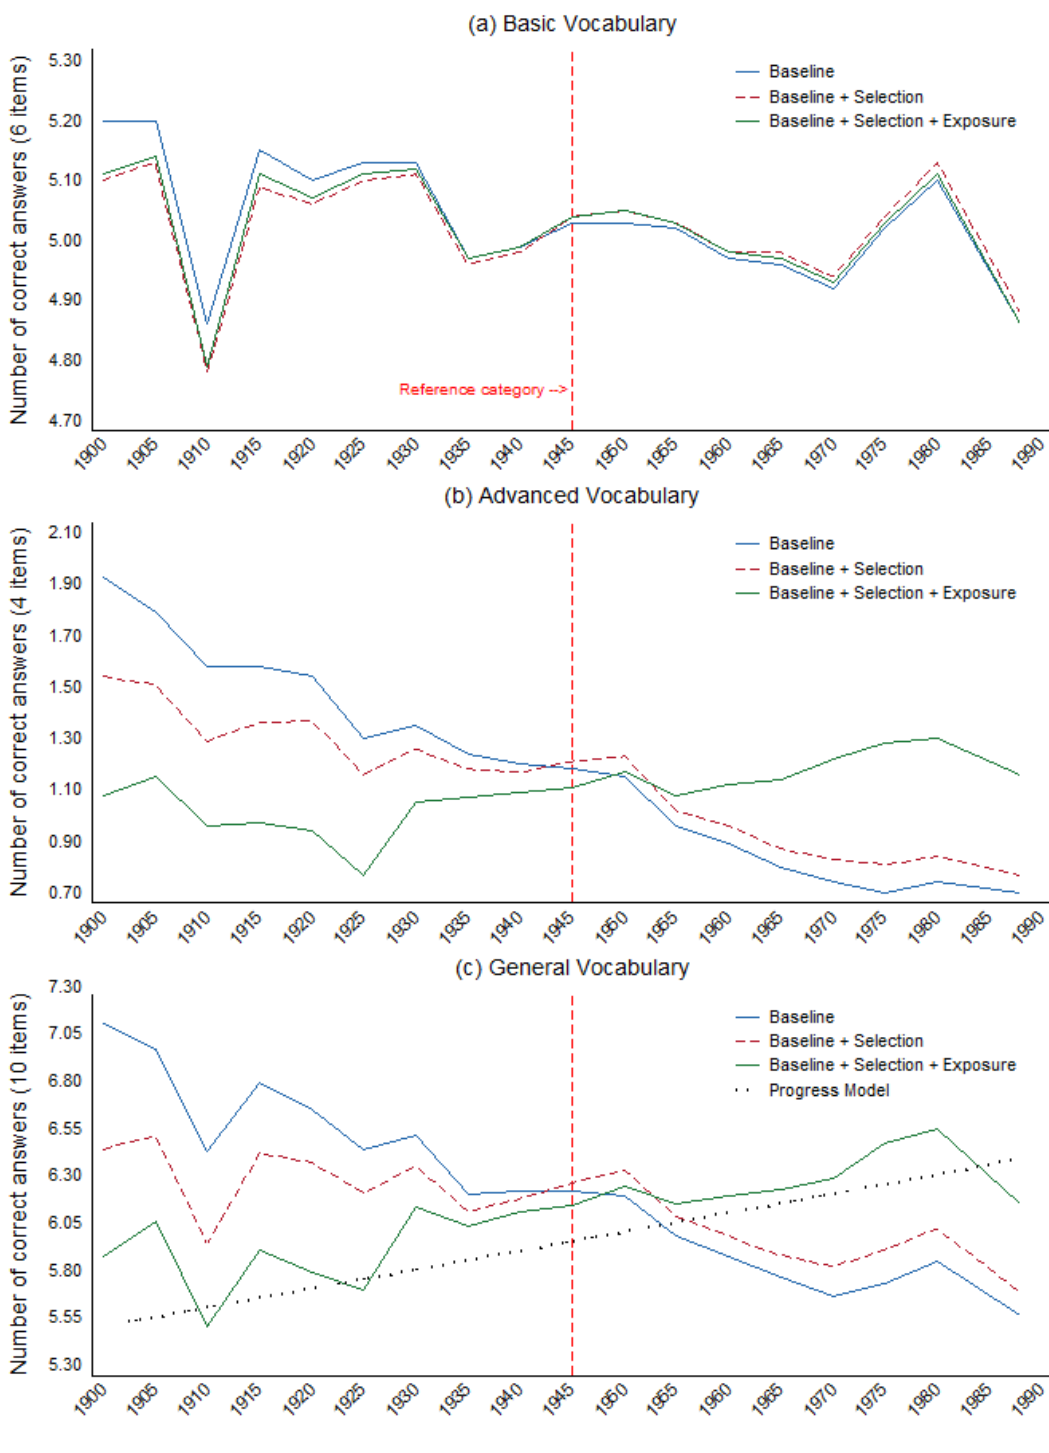
Figure 4: Adjusted cohort test scores in basic, advanced, and general vocabulary